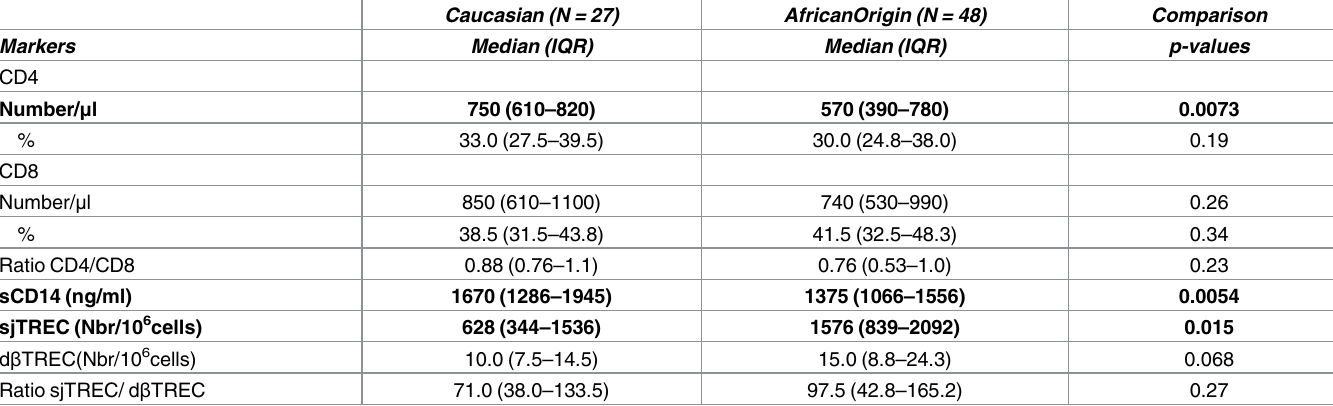
Table 2. Impact of ethnicity on observed blood markersof 75 HIV+ subjects.